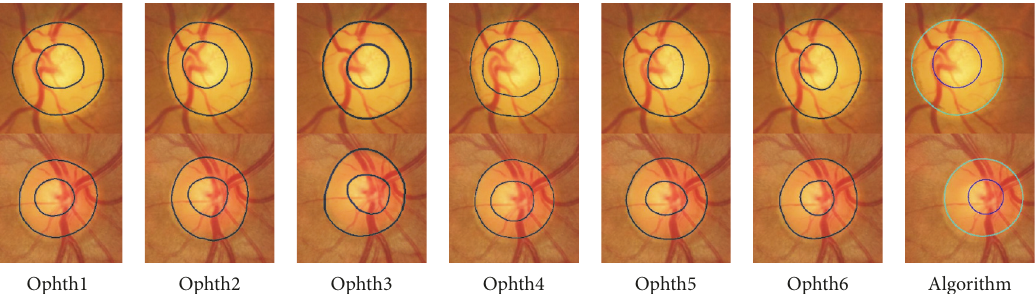
Figure 14: The algorithm final results for Bin Rushed images set.